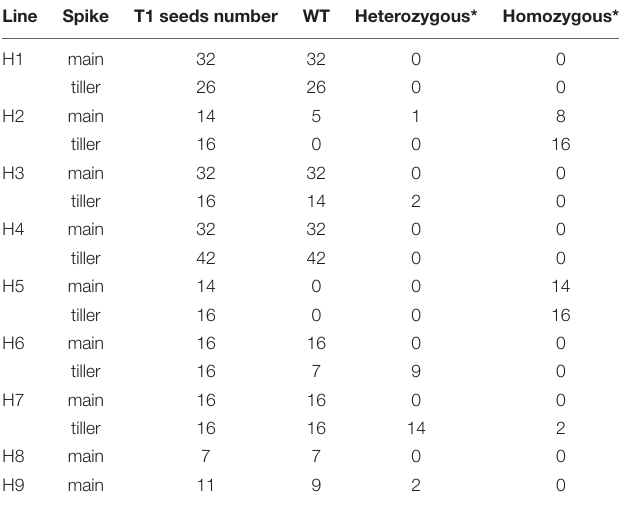
TABLE 1 | Summary of genotype analysis of T1 taqsd1 plants.